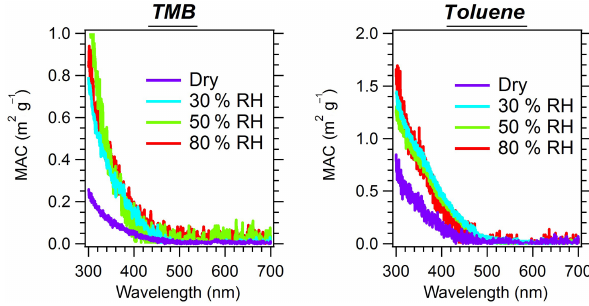
Figure 5. MAC spectra of TMB and toluene SOA formed at < 5, 30, 50, and 80%